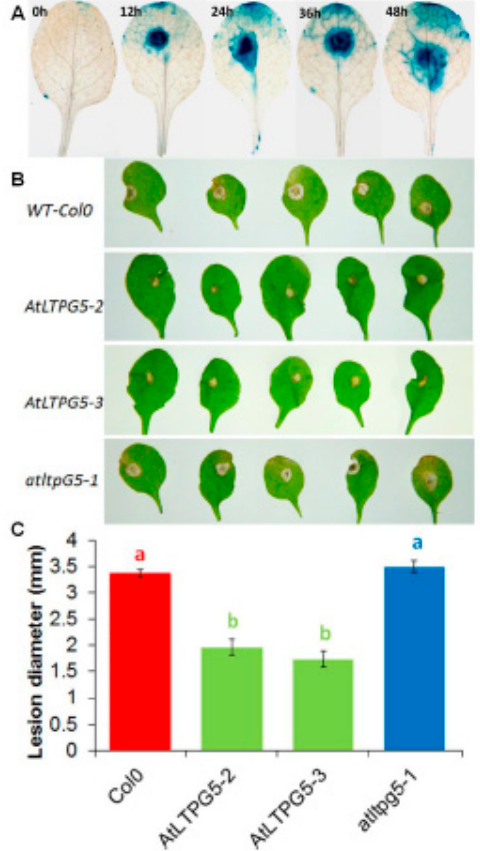
Figure 11. Expression and functional analysis of LTPg5 in response to B. cinerea infection. ( A ) Expression analysis of promoter LTPg5 ::GUS line for GUS activity in response to B. cinerea at di ff erent time points. ( B , C ) B. cinerea infection test to evaluate the involvement of LTPg5 in plant defense. The overexpression lines and mutant of LTPg5 were compared with the wild type plant after infection. Plants were infected with B. cinerea by putting a 5- µ L drop on the surface of 4-week-old leaves. Plants were grown in short day conditions with 16 h dark and 8 h light at 24 ◦ C. ( B ) The representative pictures are shown at 5 dpi. ( C ) Lesion diameter in mm was determined at 5 dpi. For each line in a replicate, three plants were infected. Mean data from three experimental replications was subjected to analysis of variance and di ff erences among mean determined by LSD at a 5 % significance level and n = 15. The values are means ± SE.